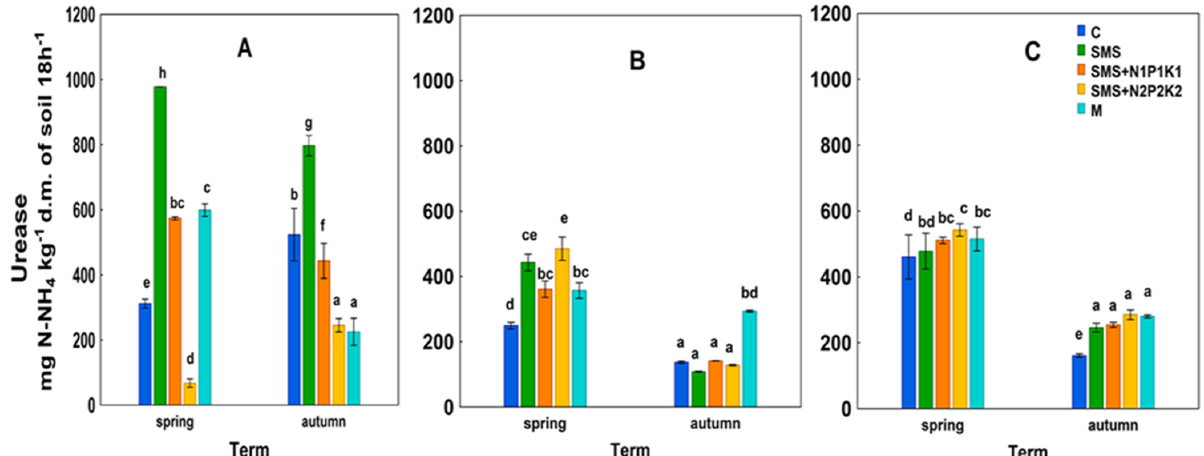
Figure 6. Activity of urease in the control soil and soil under different treatment strategies. Legend: